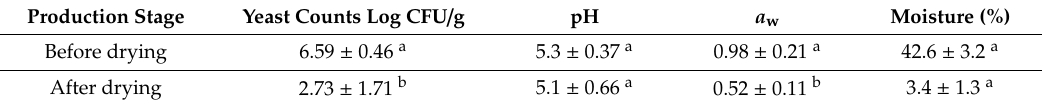
Table 1. Total yeast counts, pH, aw and moisture determined in cocoa beans before and after drying.